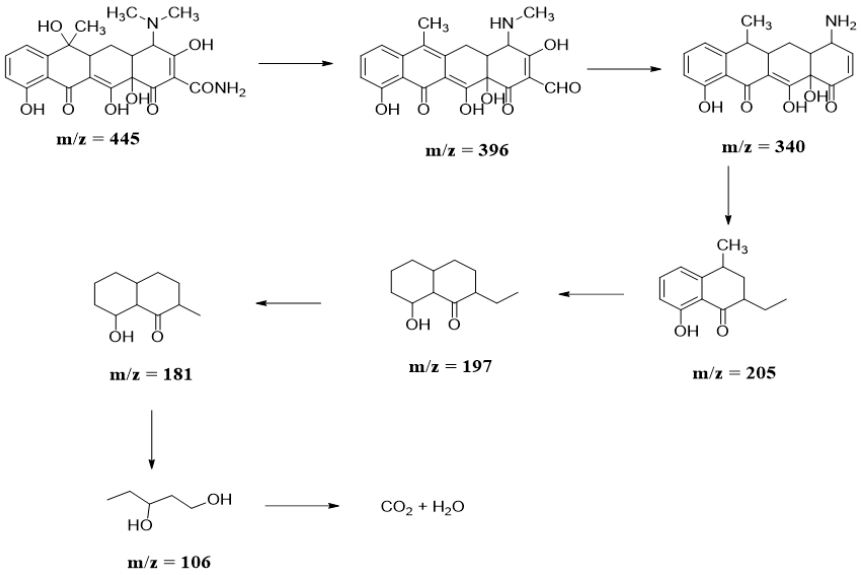
Figure 10. Proposed possible pathways for the photodegradation of TC in the presence of 8%-